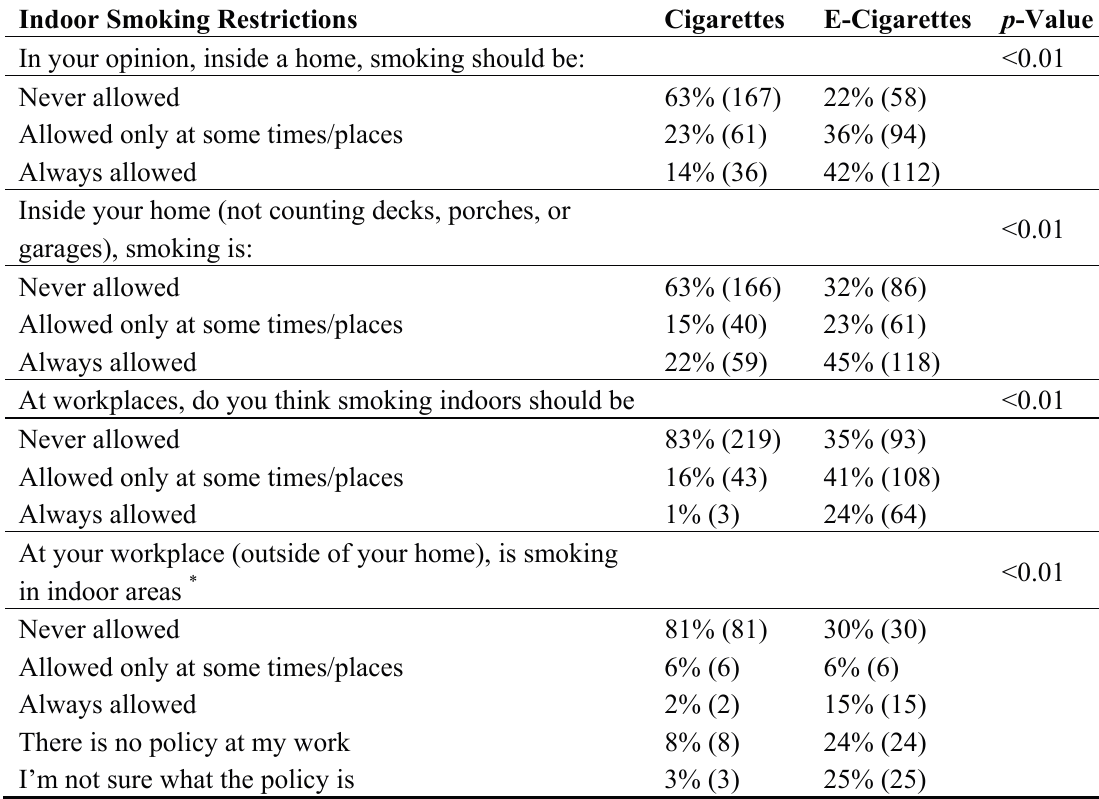
Table 2. Support for indoor smoking restrictions for e-cigarettes versus